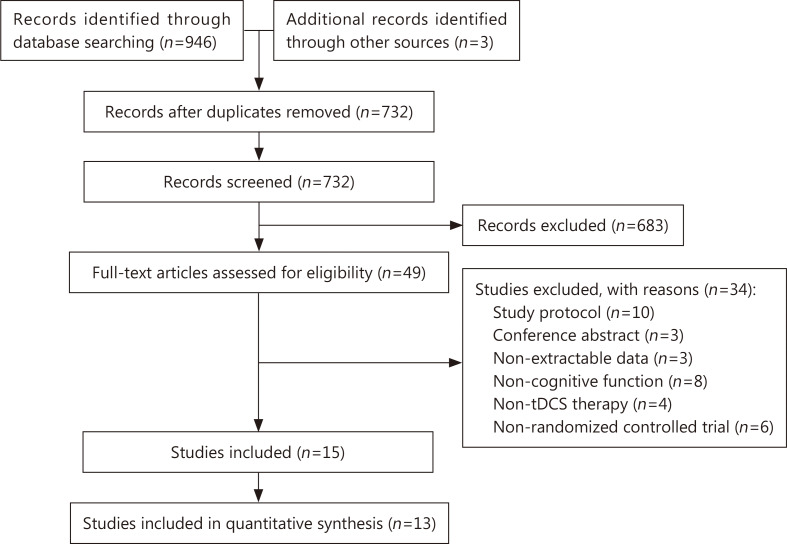
PRISMA flow diagram.